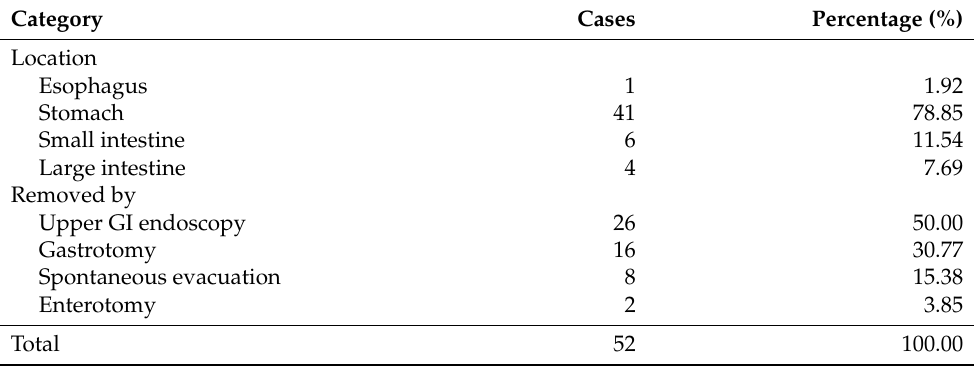
Table 10. The locations of foreign objects and methods for